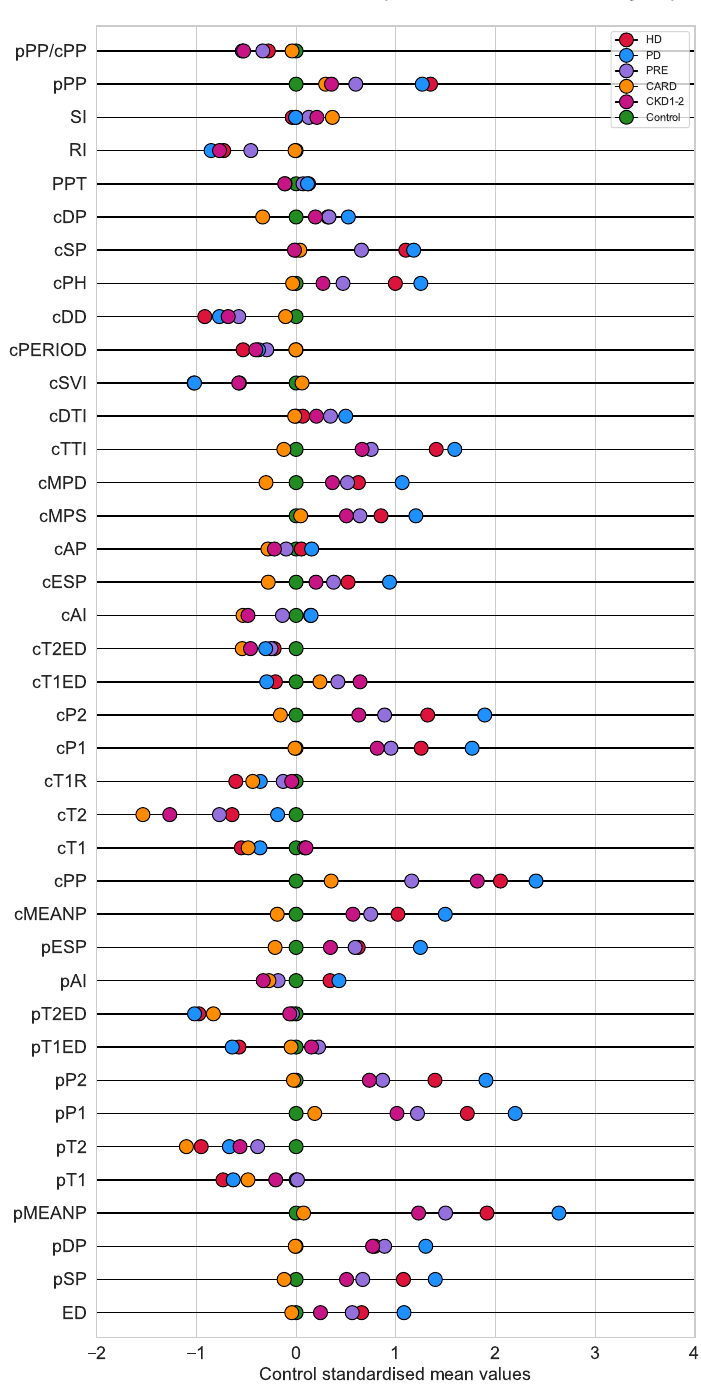
Figure 3. Visualization of differences between the groups made for the 39 cardiovascular parameters analyzed in this study. For each variable, values in the control group were standardized. Then, for each group, mean value transformation into a z-score according to standardization made for the control group was performed (each dot represents the z-scored average within a group). Each dot shows how much the mean parameter value calculated for the group was away from the healthy control average. The goal of the picture was to build intuition behind the direction and the magnitude of differences and similarities between the